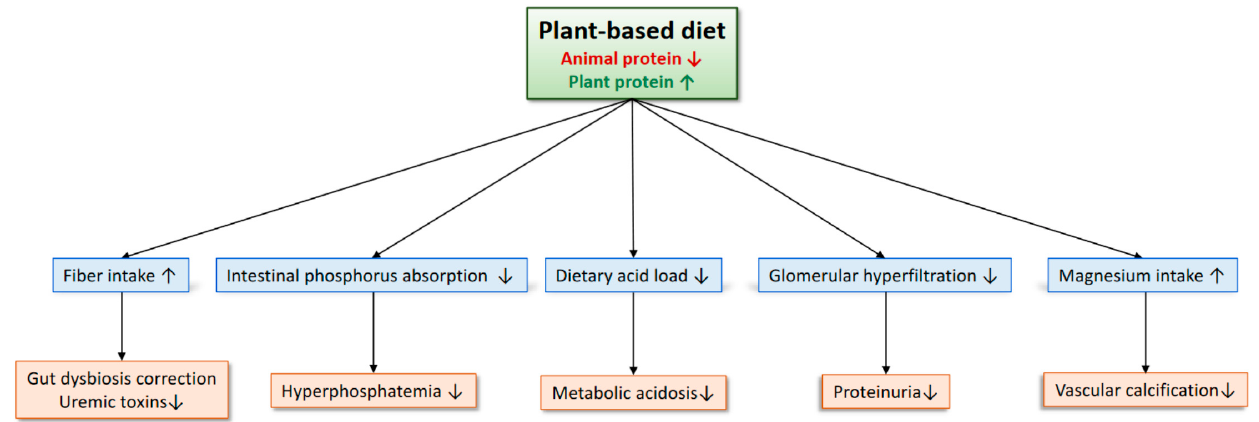
Figure 1. Potential benefits of plant-based diet for patients with CKD . Plant-based diets increase fiber intake, which may improve gut dysbiosis and reduce the production of gut-derived uremic toxins. Plant phosphorus is less absorbable than animal phosphorus because it is bound to phytates, which are difficult for humans to digest. Thus, plant-based diets contribute to reducing the phosphorus burden. Alkali-rich plant foods reduce dietary acid load and correct metabolic acidosis. Plant proteins are less likely to induce glomerular hyperfiltration compared to animal proteins. Finally, plant-based diets increase magnesium intake, which may prevent vascular calcification. ↑ : in-